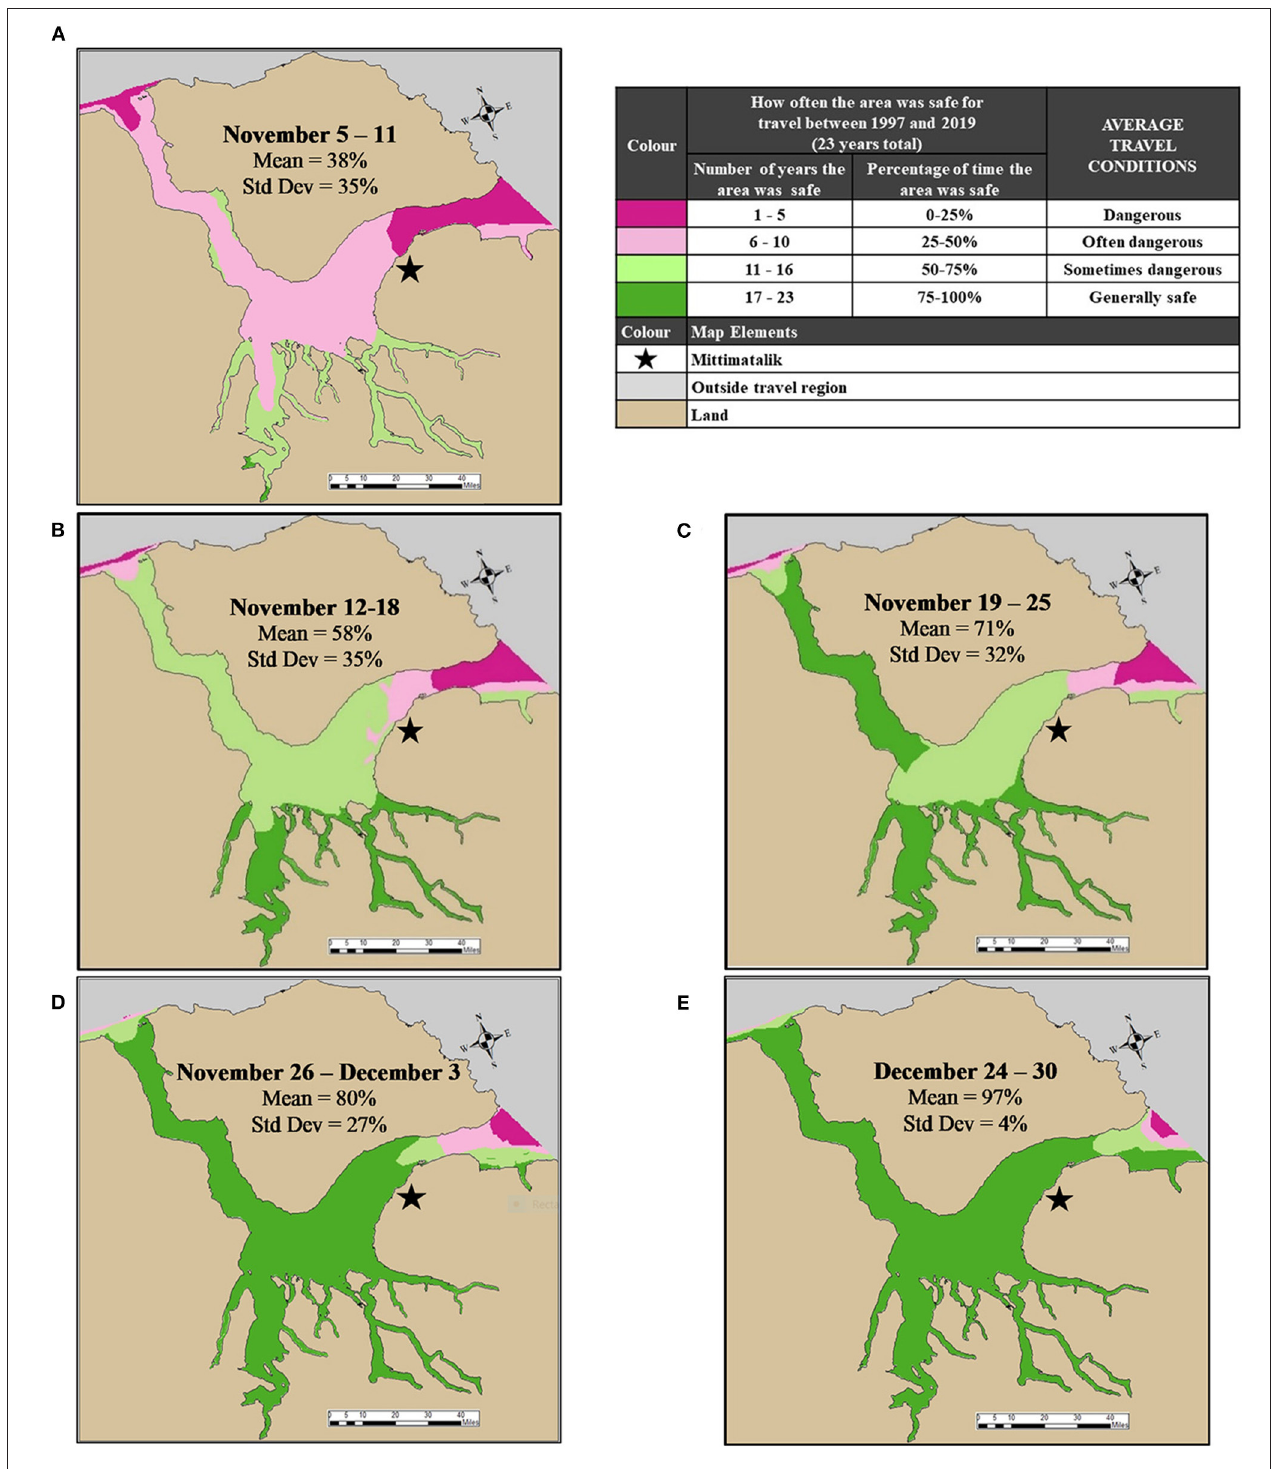
FIGURE 5 | Weekly average tuvaq maps showing freeze-up for the Mittimatalik region, 1997–2019. (A) Average tuvaq, November 5–11. (B) Average tuvaq, November 12–18. (C) Average tuvaq, November 19–25. (D) Average tuvaq, November 26–December 3. (E) Average tuvaq, December 24–30.